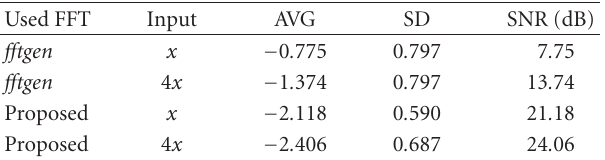
Table 2: Average (AVG) and standard deviation (SD) of the base- 10 logarithm of the relative error, and signal-to-noise ratio (SNR) in decibels for two FFT implementations, applied to the same signal on two di ff erent